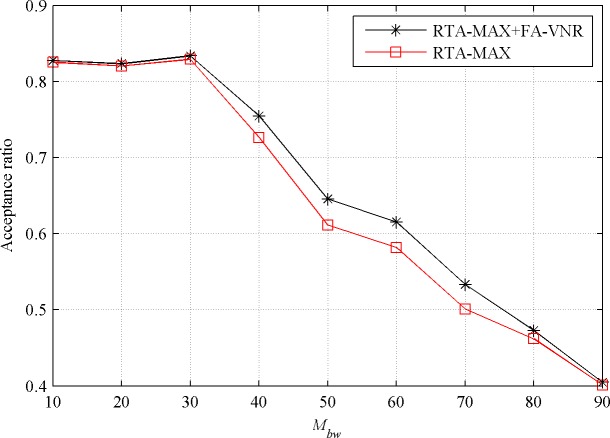
Acceptance ratio with increasing Mbw.